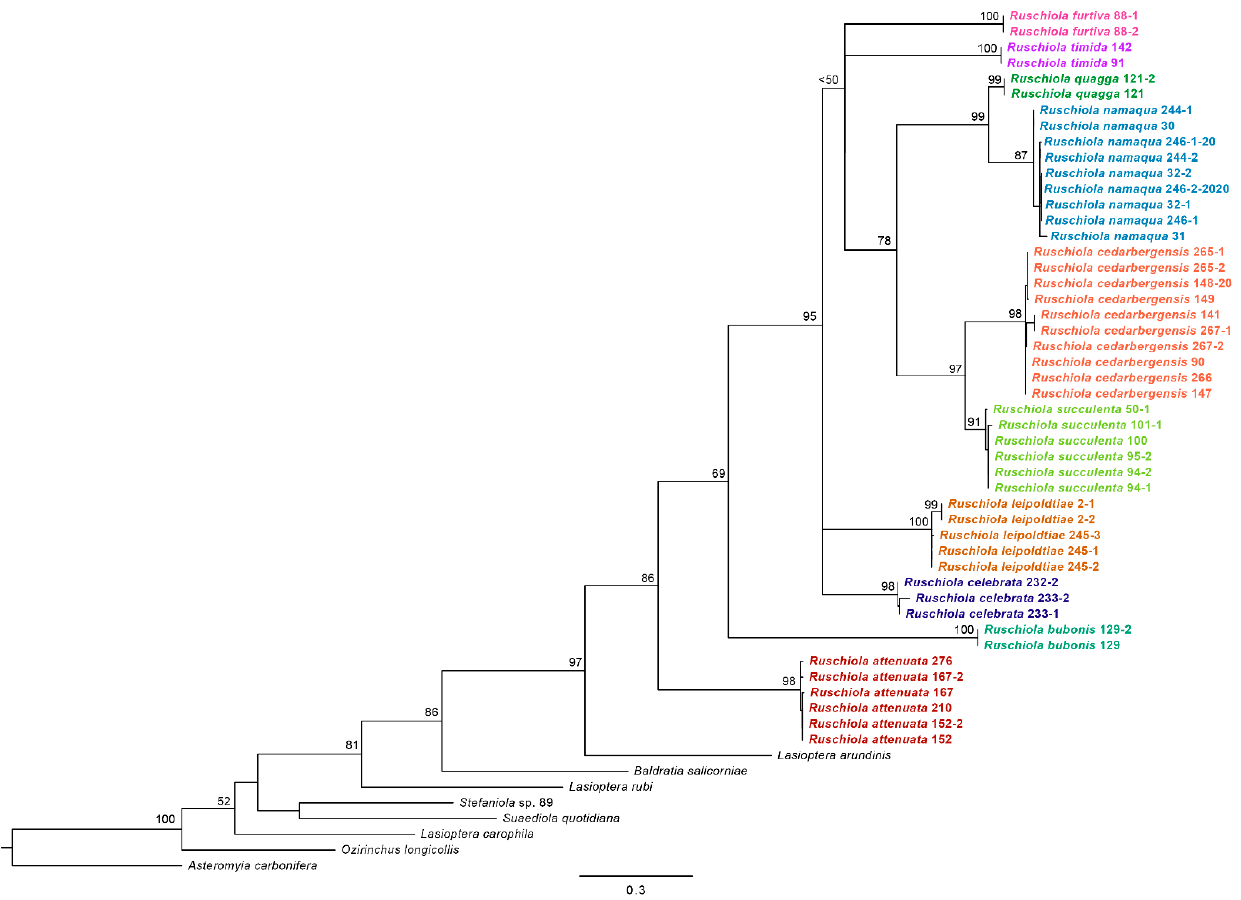
Figure 2. RAXML phylogenetic tree for the ten described Ruschiola species, color coded based on sequences of a subsection of the mitochondrial COI gene. Bootstrap support values are shown next to the nodes. Table 2. Uncorrected pairwise sequence divergences among and within the ten described Ruschiola species, calculated using Paup* [39]. Intraspecific divergences are highlighted in grey.